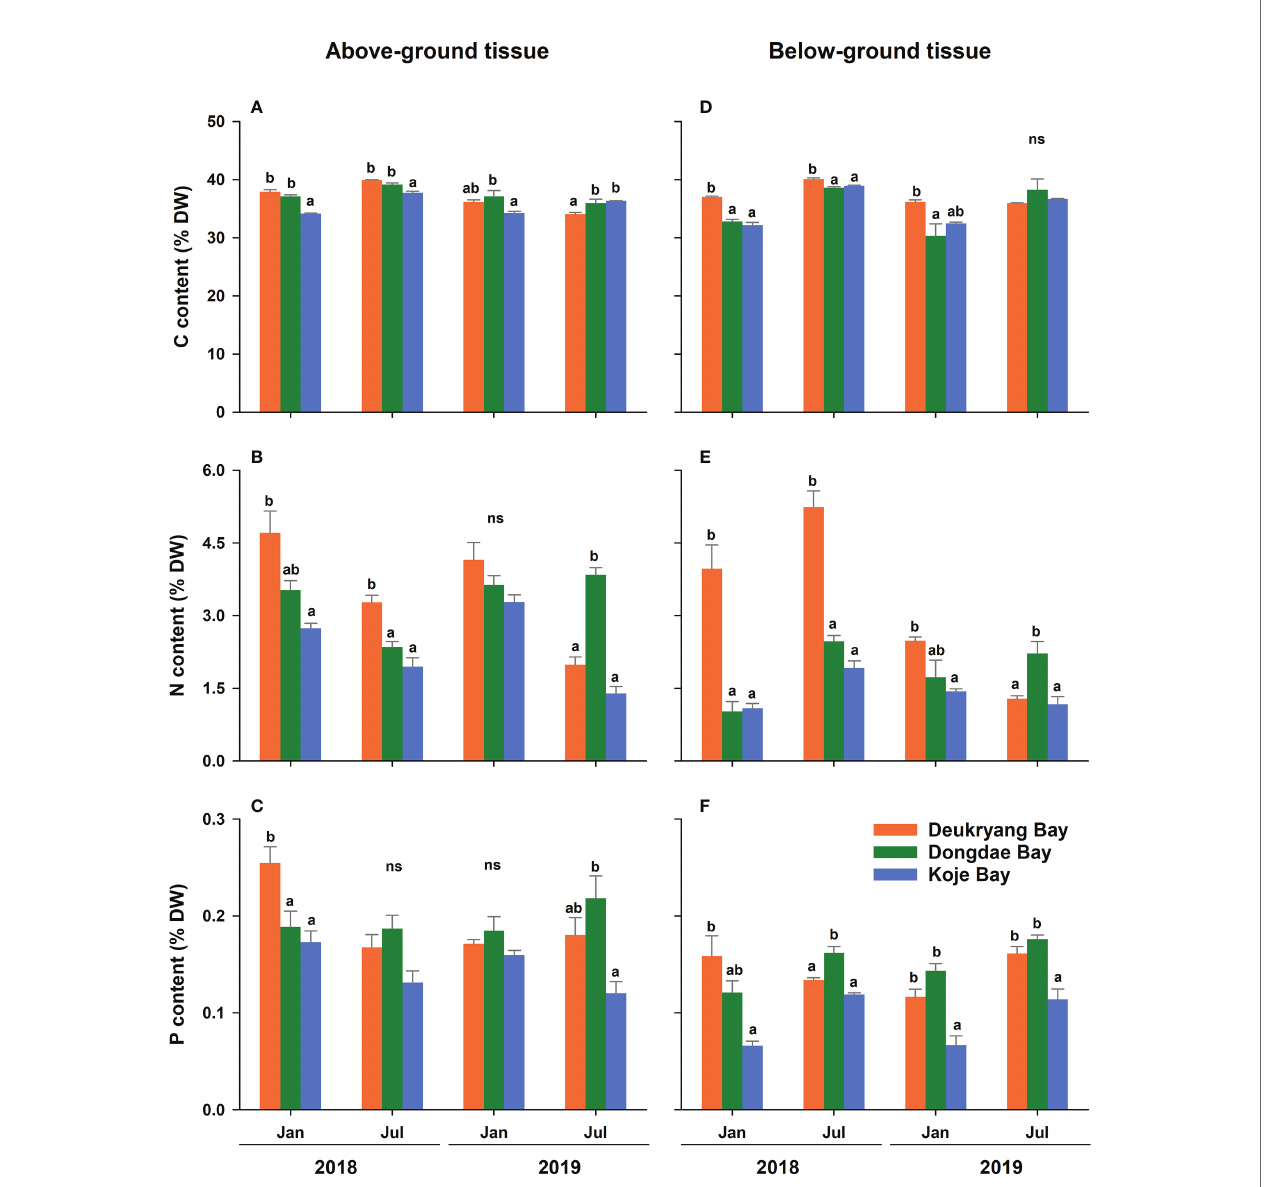
FIGURE 5 | Carbon (C), nitrogen (N), and phosphorous (P) contents in above- (A – C) and below-ground (D – F) tissues of Zostera marina in Deukryang Bay, Dongdae Bay, and Koje Bay on the southern coast of Korea. Values are means ± SE (n = 3 – 4). Different letters denote signi fi cant (p < 0.05) differences among the three study sites. ns, not signi fi